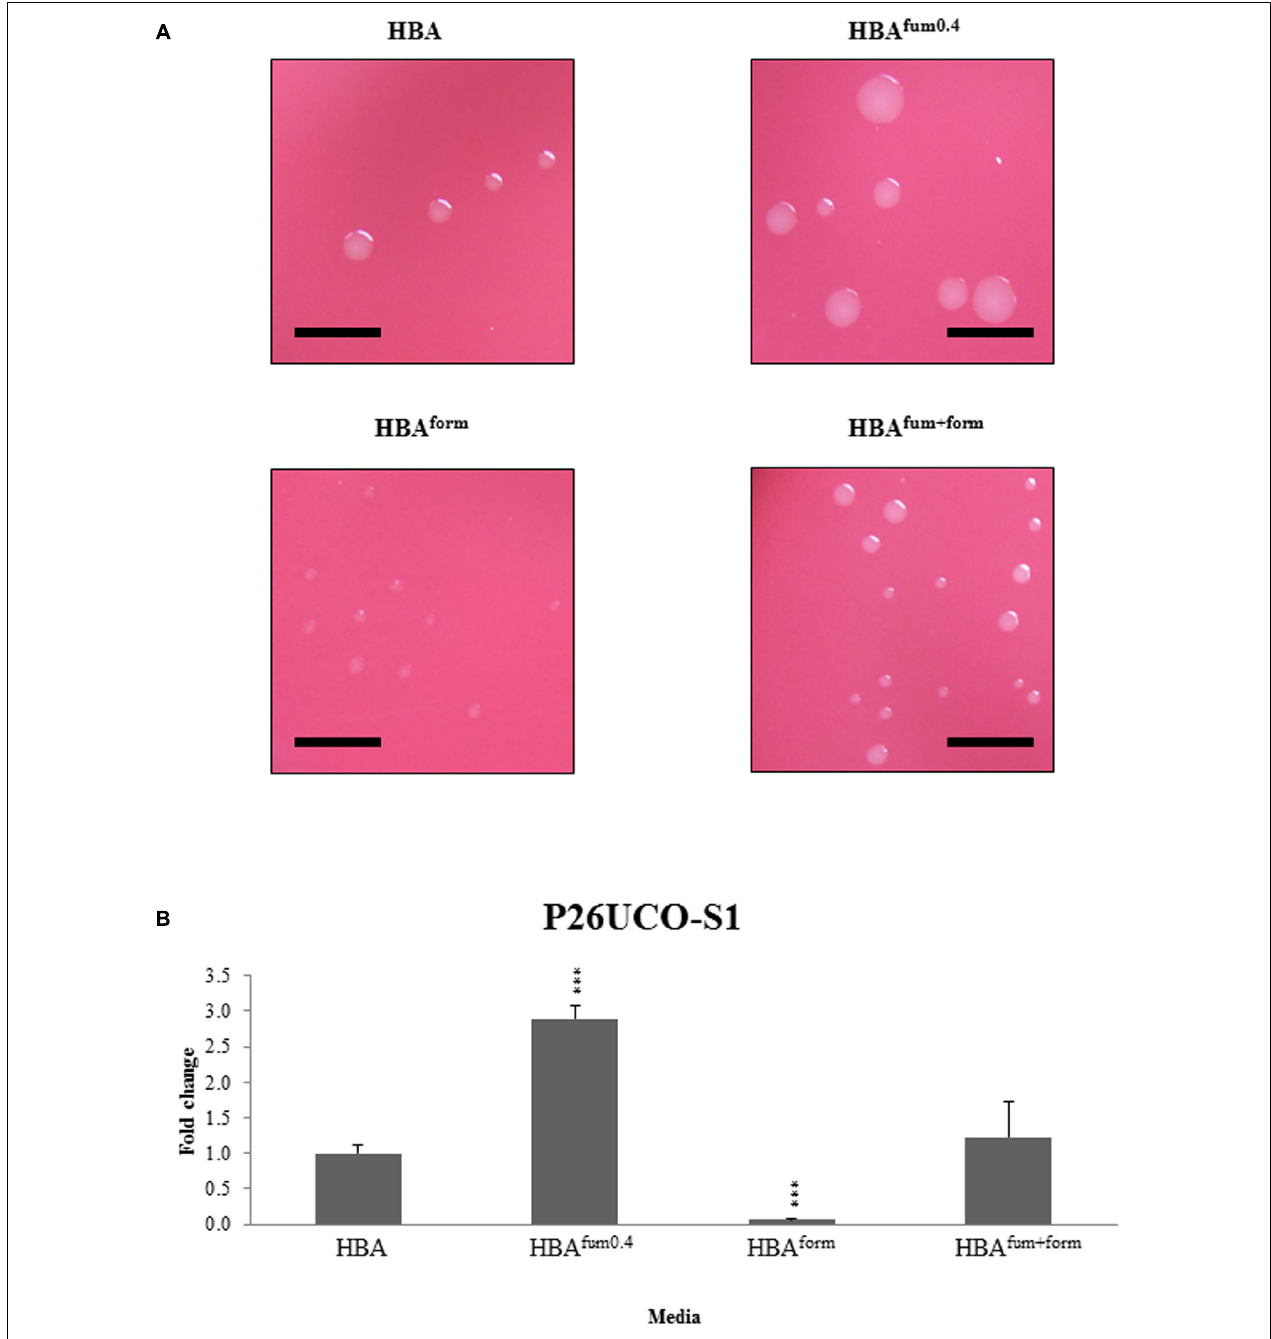
FIGURE 1 | Quantitative analysis of sodium fumarate and sodium formate on the growth of C. concisus . (A) Colonies of representative C. concisus strain P26UCO-S2. A total of five C. concisus strains were streaked onto HBA plates, HBA plates with 0.4% sodium fumarate (HBA fum0 . 4 ), HBA with 0.2% sodium formate (HBA form ), and HBA with both sodium fumarate and sodium formate (HBA fum + form ). After incubation the colonies were observed under a stereomicroscope and photographs were captured at 20 × magnification. Scale bars represent 5 mm. Of the five strains examined, all showed increased colony size when cultured on HBA fum0 . 4 and decreased colony size on HBA form . All strains showed no visible difference in colony size when cultured on HBA fum + form . (B) The fold changes in CFU of C. concisus strain P26UCO-S2 cultured on HBA, HBA fum0 . 4 , HBA form , and HBA fum + form is shown. Fold changes were calculated relative to the CFU of the same strain cultured on plates without fumarate or formate from the mean of quadruplicate counts on each media. ∗∗∗ indicates p < 0.001.